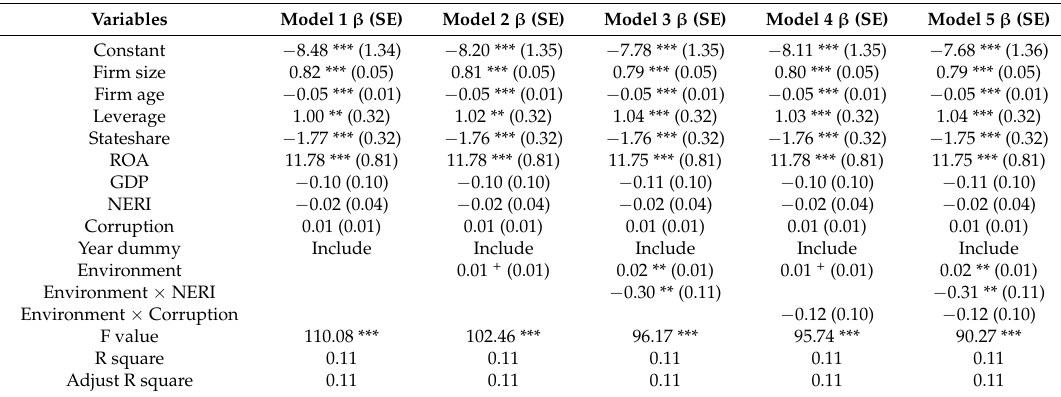
Table 4. Robustness checks for OLS linear regression on corporate philanthropy.